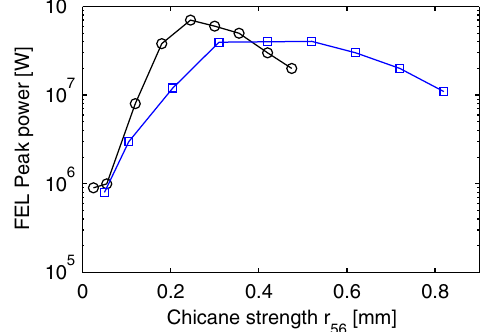
FIG. 18. FEL peak power at 40 nm at the undulator exit versus chicane strength using a magnification of (black circle) 15 and (blue square) 20. Beam transport simulation in the nonlinear case with BETA and sympletic 6D tracking without collective effects using the S2I-CM optics with a 400 MeV beam. FEL simulation with GENESIS.